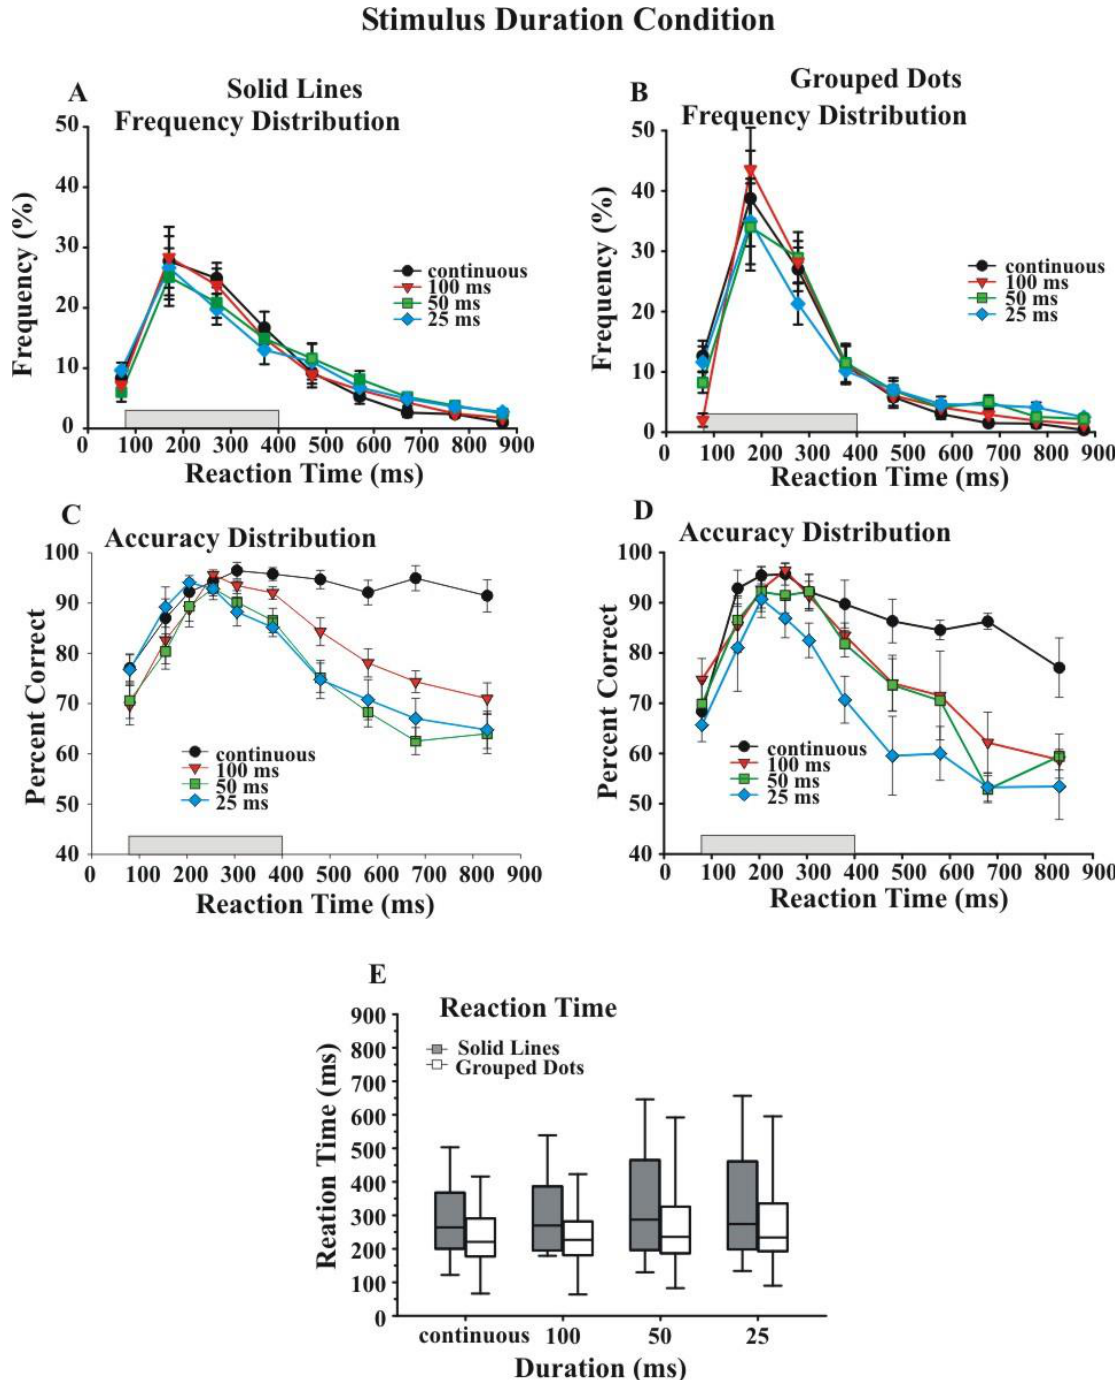
Figure 3 . Performance with solid-line and grouped-dot stimuli across levels of stimulus duration. RT are relative to stimulus onset, and each data point for A-D represents the mean performance across rats. A and B : Response frequency distributions; C and D : Percent correct for pattern discrimination across bins of RT. Error bars represent SEM. Shaded region depicts period during which reward could be delivered during training. E : Reaction time across duration for solid-line and grouped-dot stimuli. Center lines depict median, box borders depict 25 th and 75 th percentiles, error bars depict 10 th and 90 th